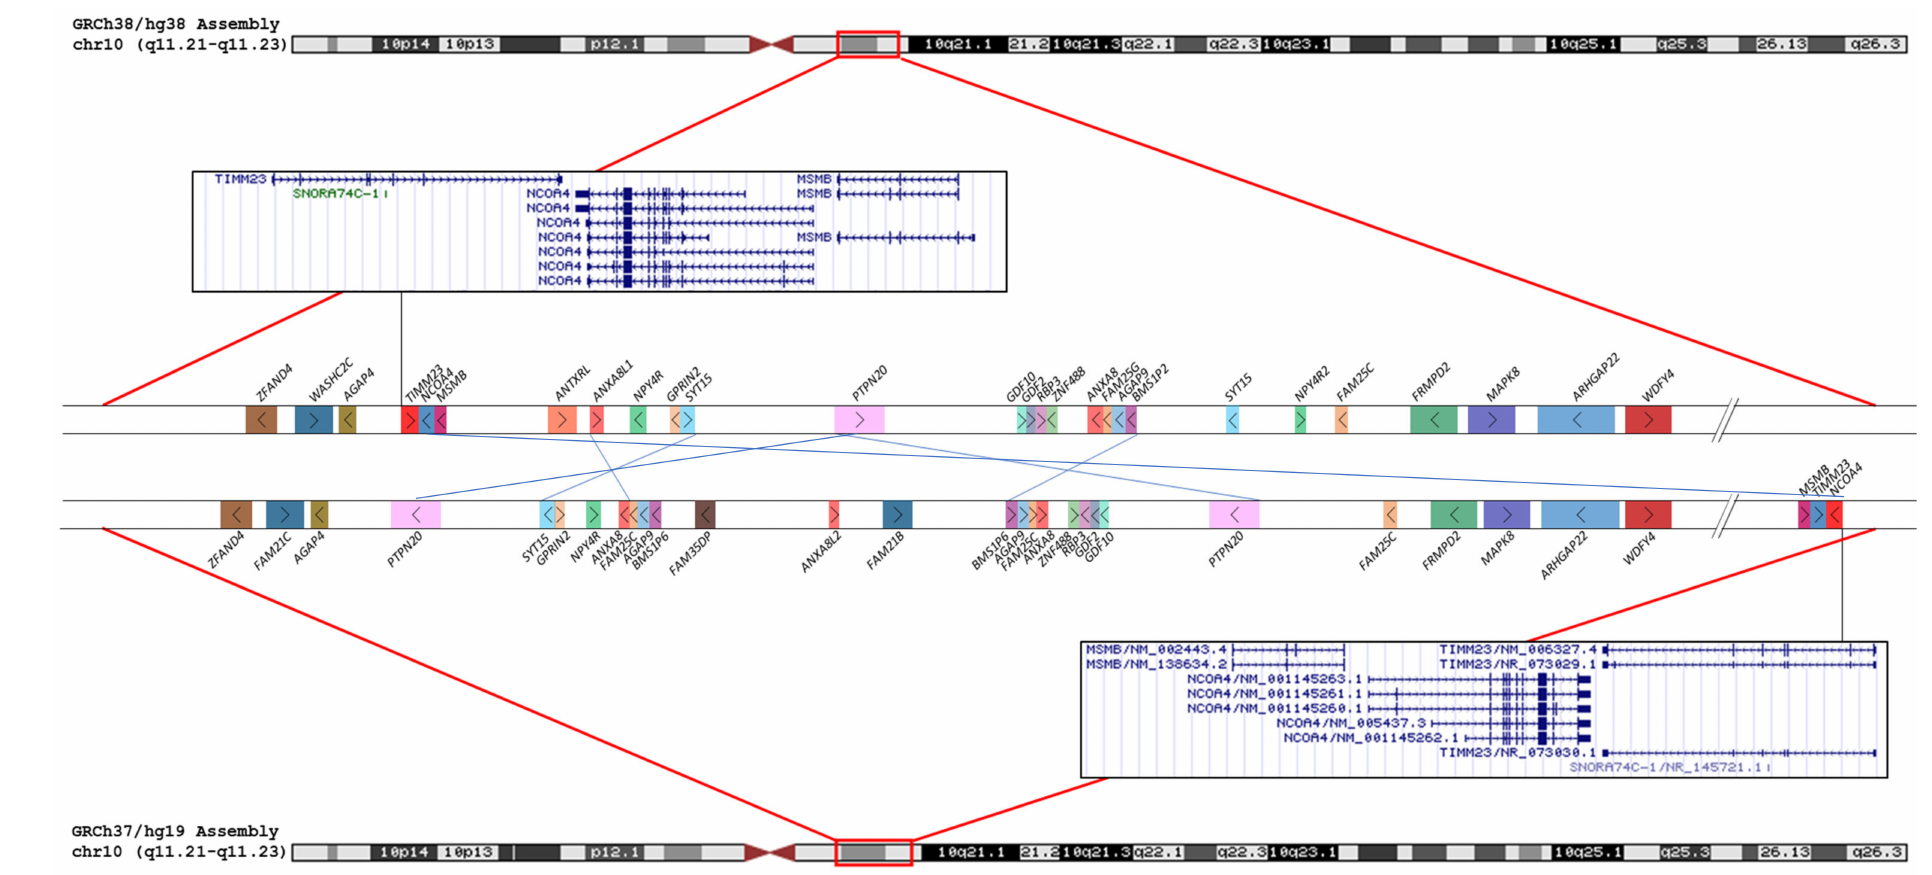
Figure 12. Differences in organization of the 10q11-q11.23 region between the GRCh38/hg38 and GRCh37/hg19 human genome assemblies. Blue lines denote changes in the gene’s blocks position and